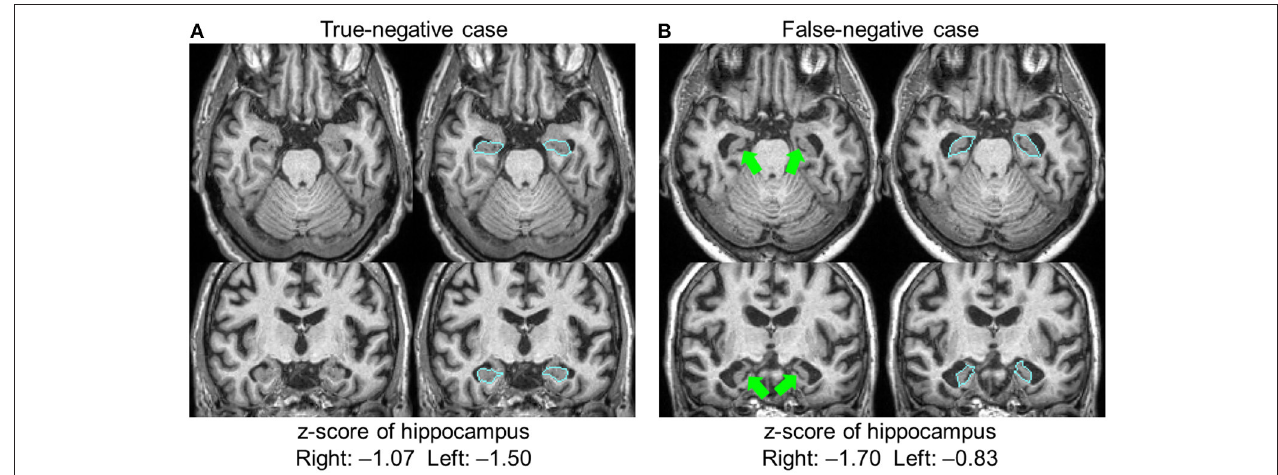
FIGURE 3 | Two examples of hippocampal segmentation. Both cases had a similar degree of atrophy based on the quantification results, with z-scores higher than − 2.0; both were judged as normal and automated sentences were not triggered. The radiologists agreed that Case (A) was normal (true-negative), but Case (B) was judged to be atrophic (false-negative). In this case, the opening of the uncal sulci (arrows) was a factor in the radiologists’ judgment. Blue lines show the boundary of the